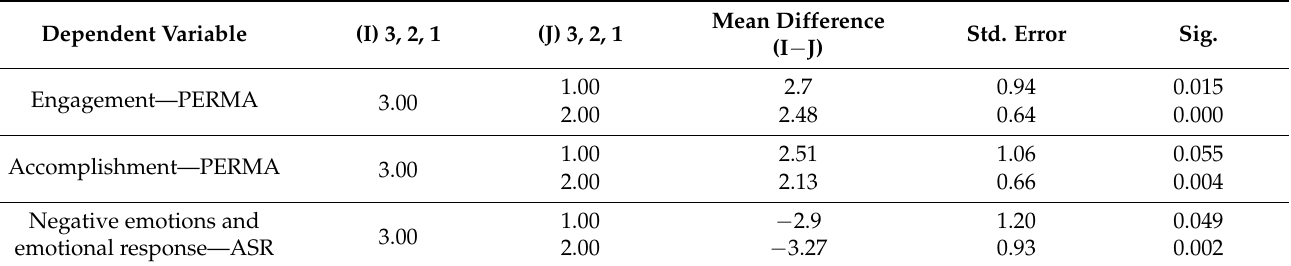
Table 7. Differences (one-way ANOVA) depending on achievement levels at the end of the first year (H2.3b).